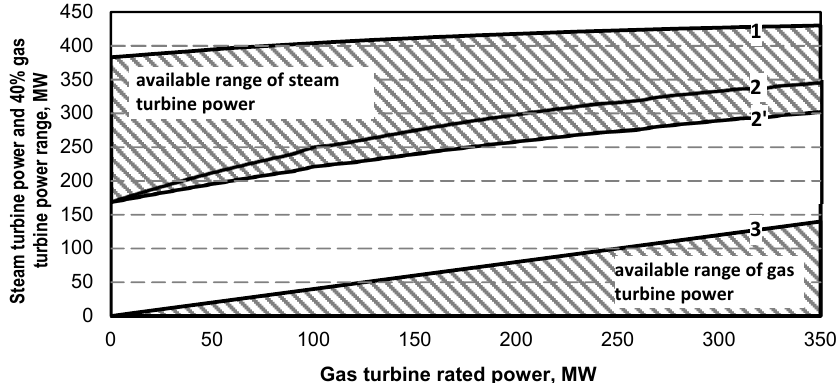
Figure 38. The stream of outlet steam from the low-pressure steam turbine part to the KQ1 condenser as a function of gas turbine rated power: 1 — maximum fixed stream of 319.4 kg/s fresh steam fed to steam turbine; 2 — minimum steam boiler output of 133.3 kg/s and gas turbine operating at a rated power, 2’ — minimum steam boiler output of 133.3 kg/s and gas turbine operating with 60% of its rated power.